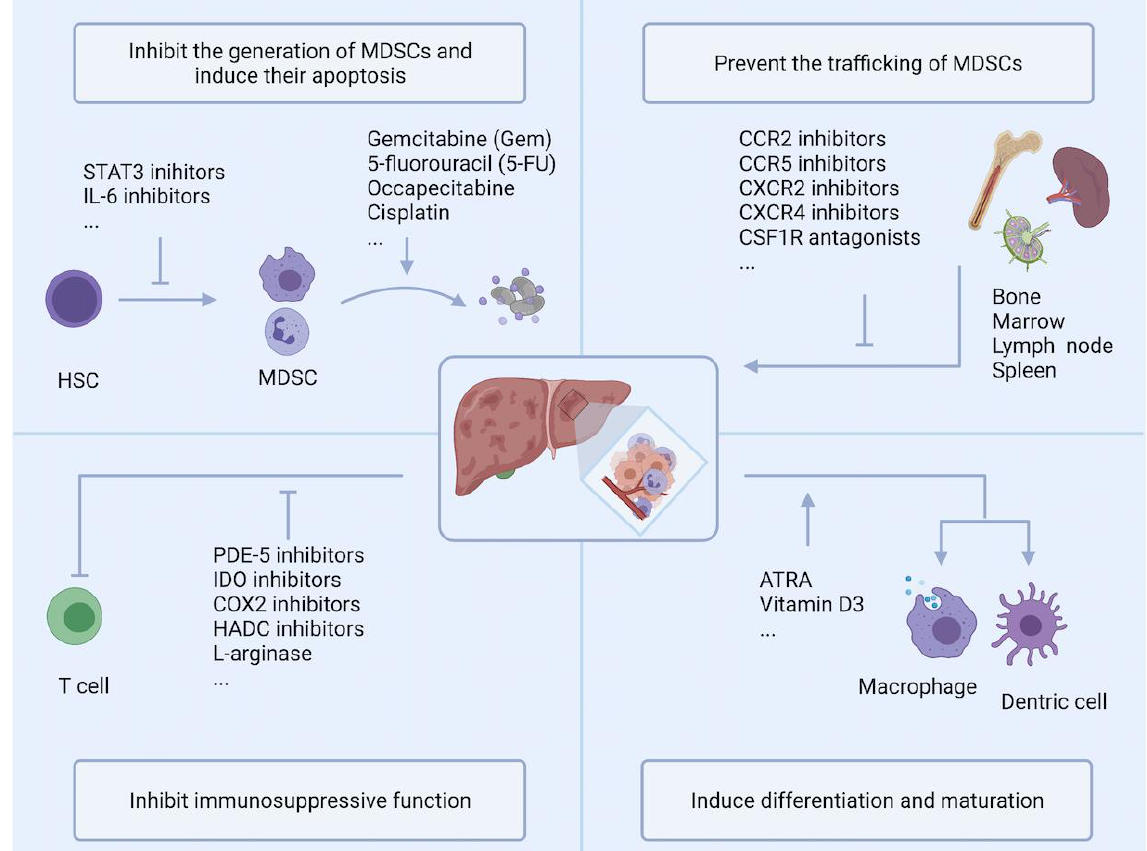
Figure 2. Strategies targeting MDSC can be roughly divided into four categories: Inhibition of MDSCs generation and induction of their apoptosis; Prevention of MDSCs trafficking; Inhibition of immunosuppression; Induction of MDSCs differentiation and maturation. PDE-5: Phosphodiesterase 5; IDO: indoleamine 2,3-dioxygenase; COX2: cyclooxygenase 2; HDAC: histone deacetylase; ATRA: All-trans retinoic acid.